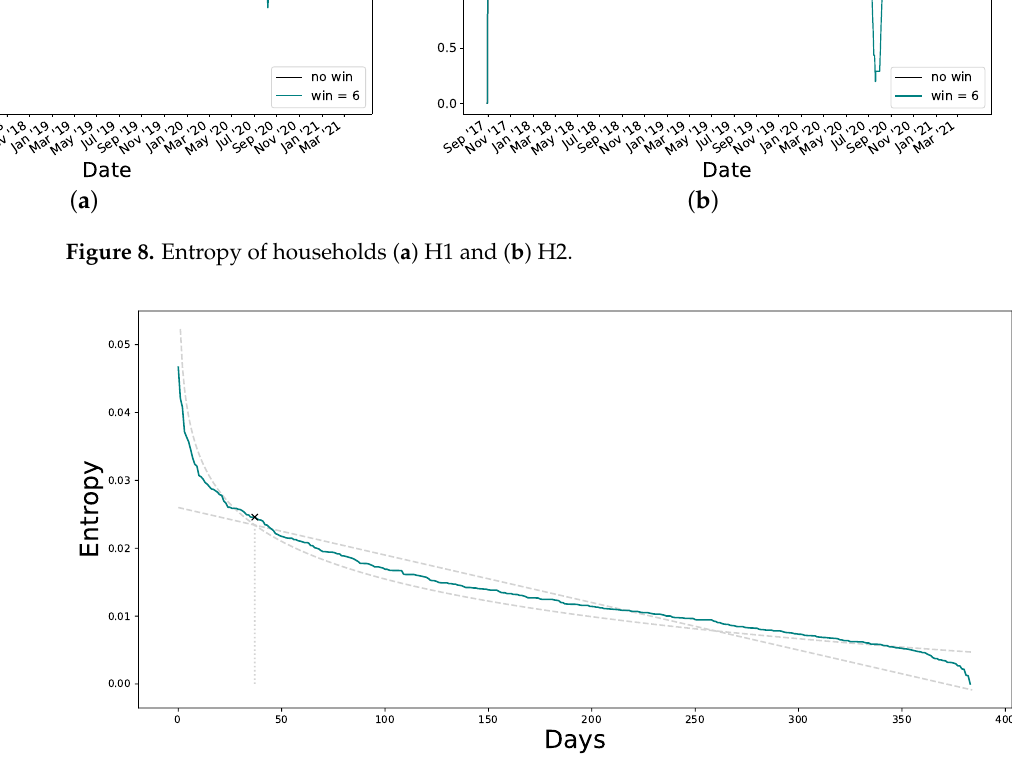
Figure 9. Days ordered by entropy